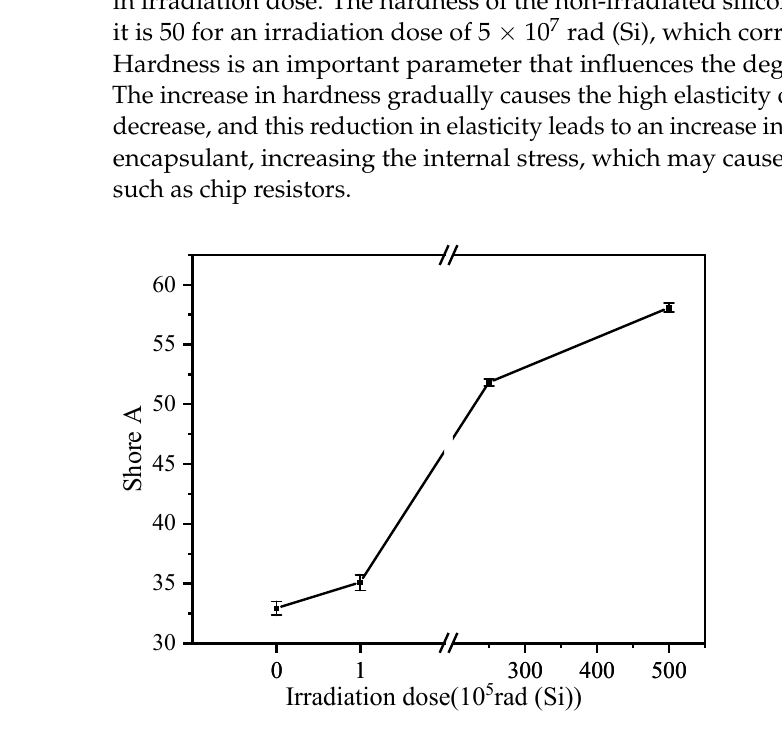
Figure 9. Changes in hardness under different irradiation conditions.